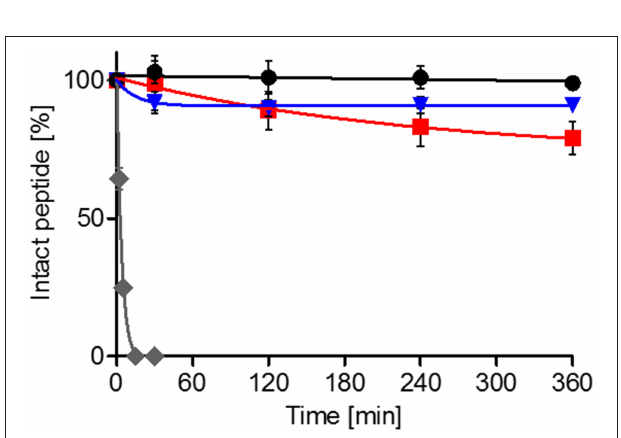
FIGURE 5 | Stability of Api137 (black), Api795 (blue), and Api794 (red) in the presence of elastase. Peptides (0.5 g/L) were incubated with P. aeruginosa elastase (12 units/mL) in Tris-HCl buffer (pH 8.3) at 37 ◦ C and quantified by RP-HPLC. Peptide quantities are shown relative to the initial peak area (0 min). LL-37 (gray) was used as positive